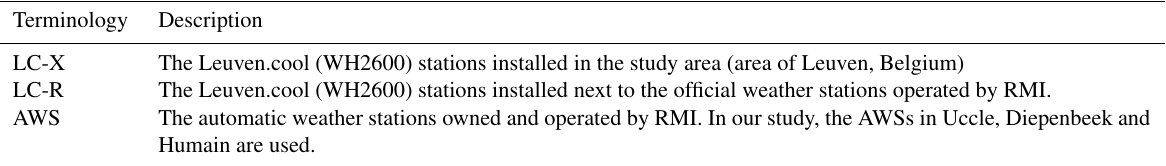
Table 4. Terminology of datasets and stations used in this